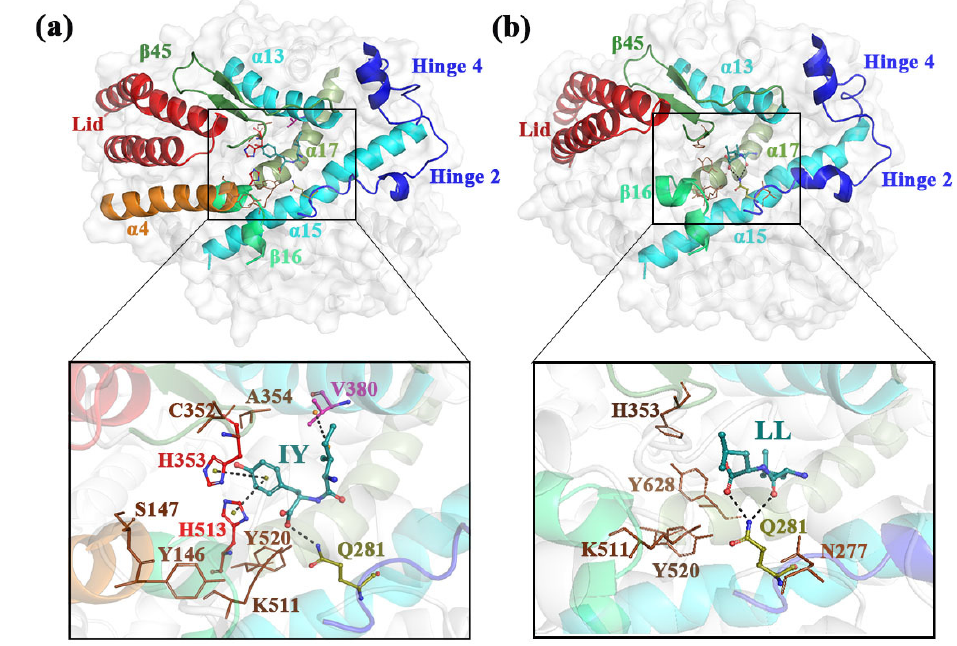
Figure 7. Schematic diagram of bridging of inhibitors across the active site cleft for ( a ) ACE–IY and ( b ) ACE–LL complexes. ACE–IY stands for complex system of protein and dipeptide Ile-Tyr, ACE–LL represents the complex system of protein and dipeptide Leu-Leu.